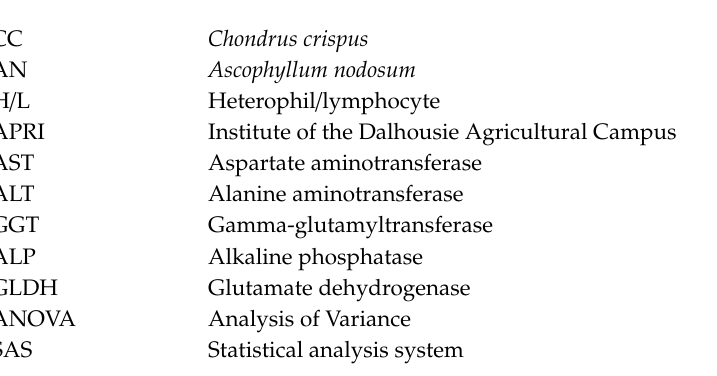
Table S1: Chemical composition of seaweeds, Chondrus crispus and Ascophyllum nodosum , in 100 g of fresh